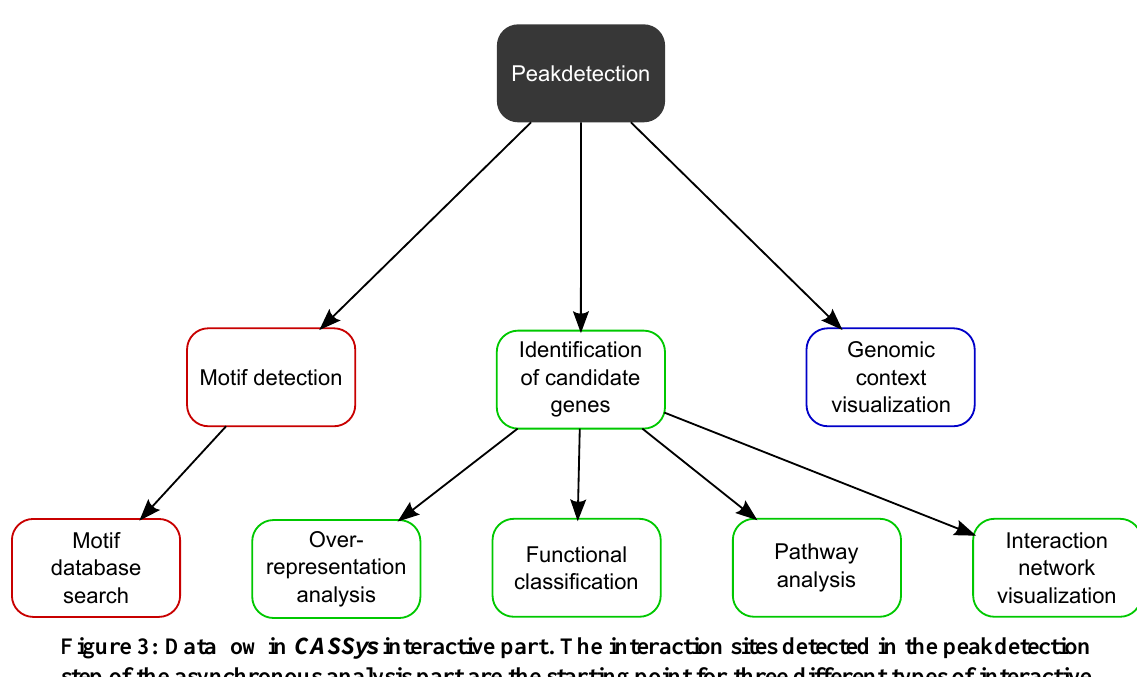
Figure 3: Dataflow in CASSys interactive part. The interaction sites detected in the peakdetection step of the asynchronous analysis part are the starting point for three different types of interactive analyses in CASSys . The sites are screened for sequence motifs and detected motifs can then be compared to known motifs listed in motif databases (red). A set of candidate genes is constructed and further analyzed (green). The interaction sites can be explored in their genomic context using the CASSys ’ genome browser